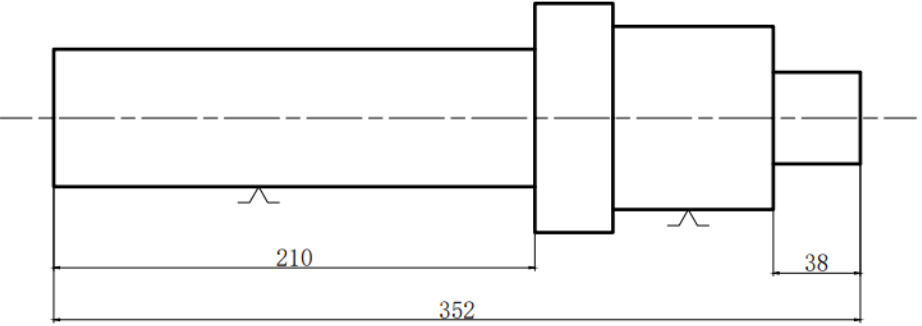
Figure 2. The engineering drawing of the workpiece blank.